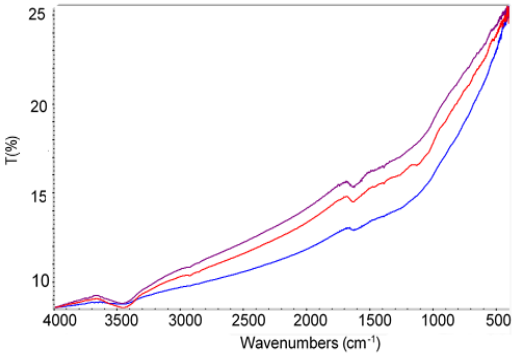
Figure 4. The FTIR spectra of the carbon black samples: CB-NM (blue line), CB-APTES (red line), and CB-Ox (purple line).